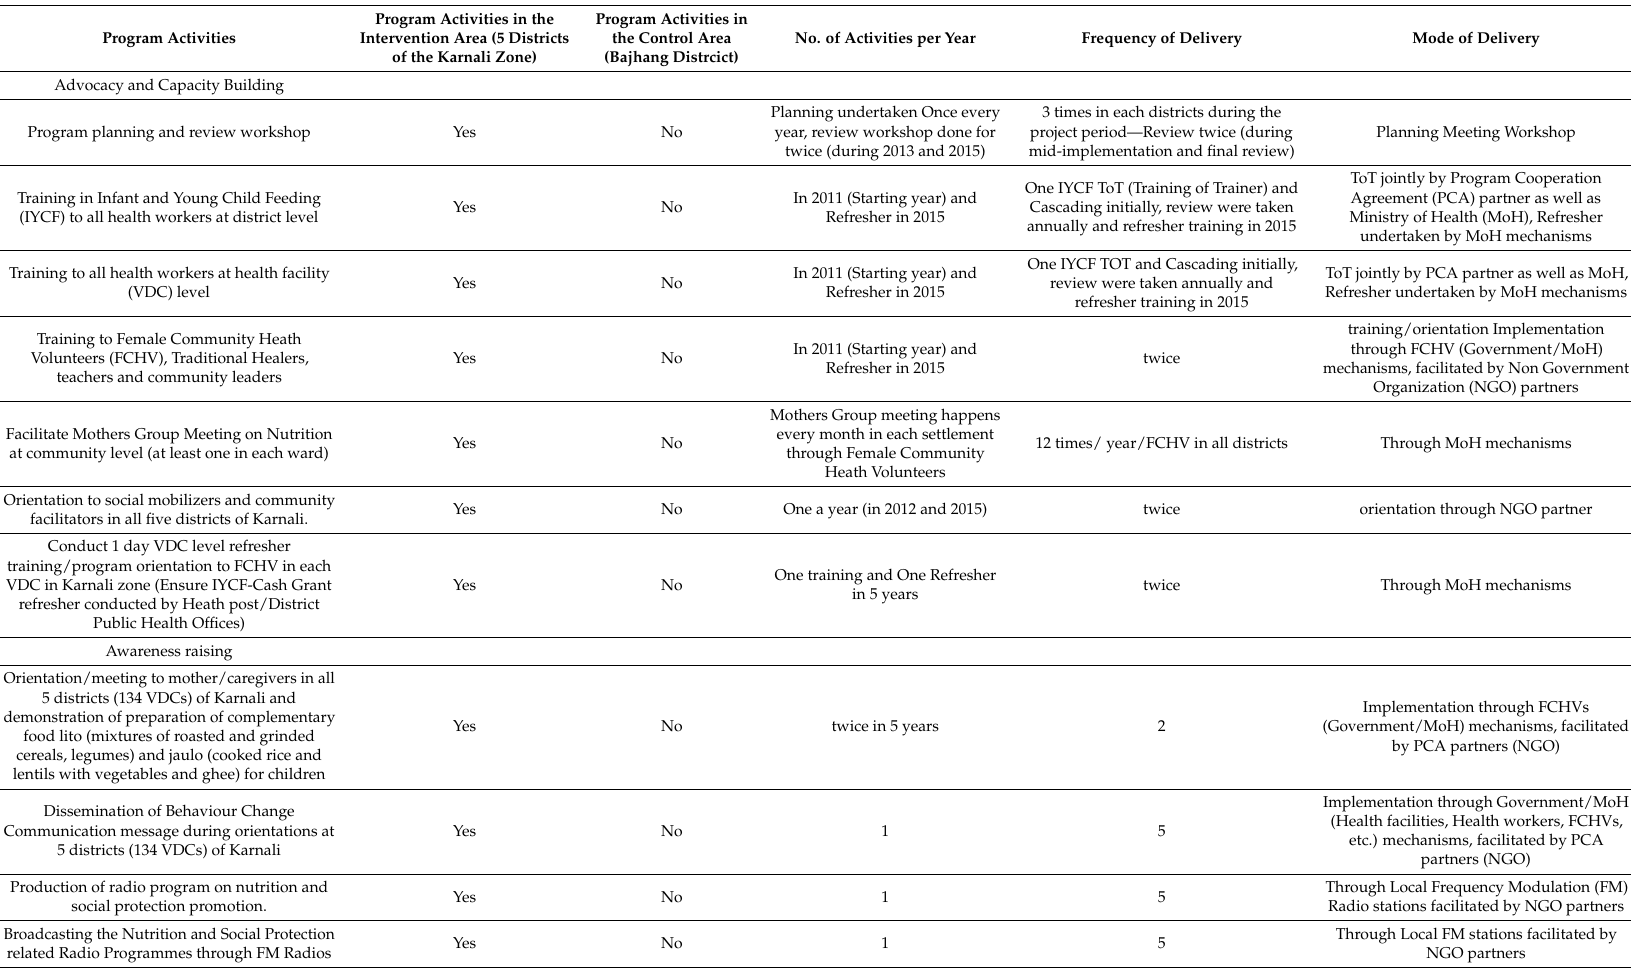
Table 1. UNICEF-supported intervention to improve child health outcomes through CCG (child cash grant)